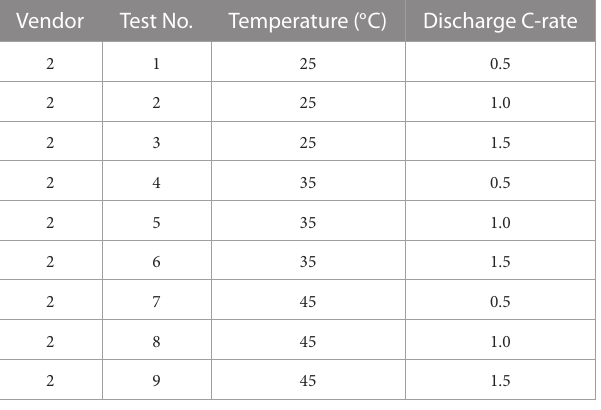
TABLE1 UMDCALCEdatasettestconditionsusedinthispaper. Vendor